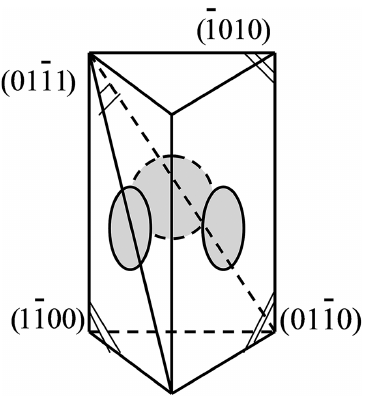
Figure 5: Schematic drawings of the crystallographic orientation relationships between Ti 2 Cu plates and slip planes of α -Ti matrix.